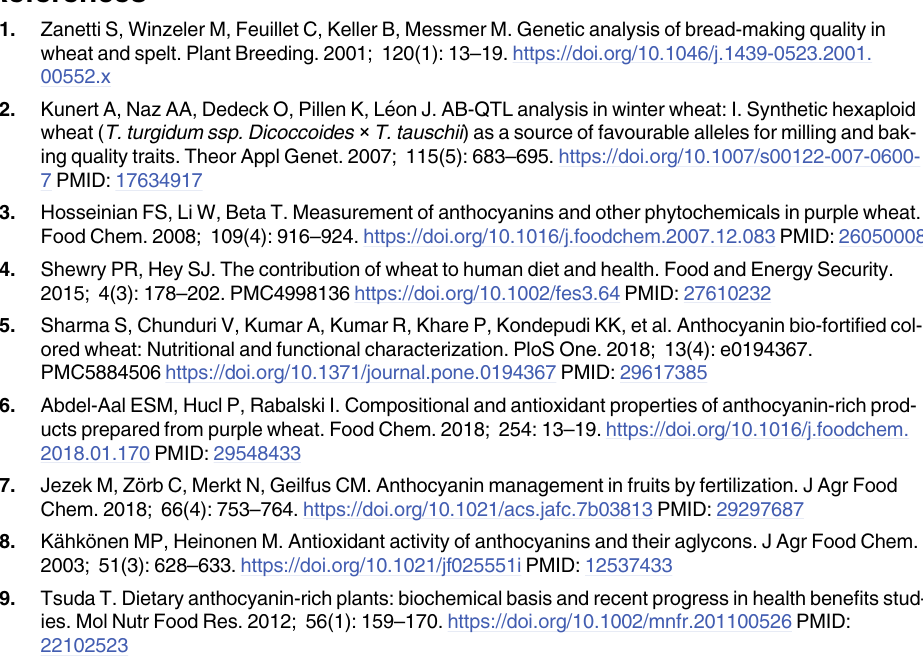
S6 Table. Average and AMMI stability value (ASV) of processing quality traits and grain morphology traits for the blue wheat lines. S7 Table. Average and AMMI stability value (ASV) of processing quality traits and grain morphology traits for the blue wheat lines. S1 Fig. AMMI analysis of blue wheat lines for processing quality traits and grain morphol- ogy traits. S2 Fig. AMMI analysis of purple wheat lines for processing quality traits and grain mor- phology